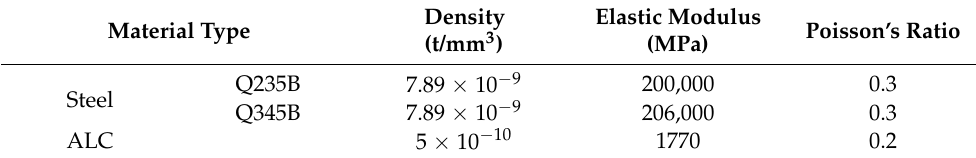
Table 4. Material properties.